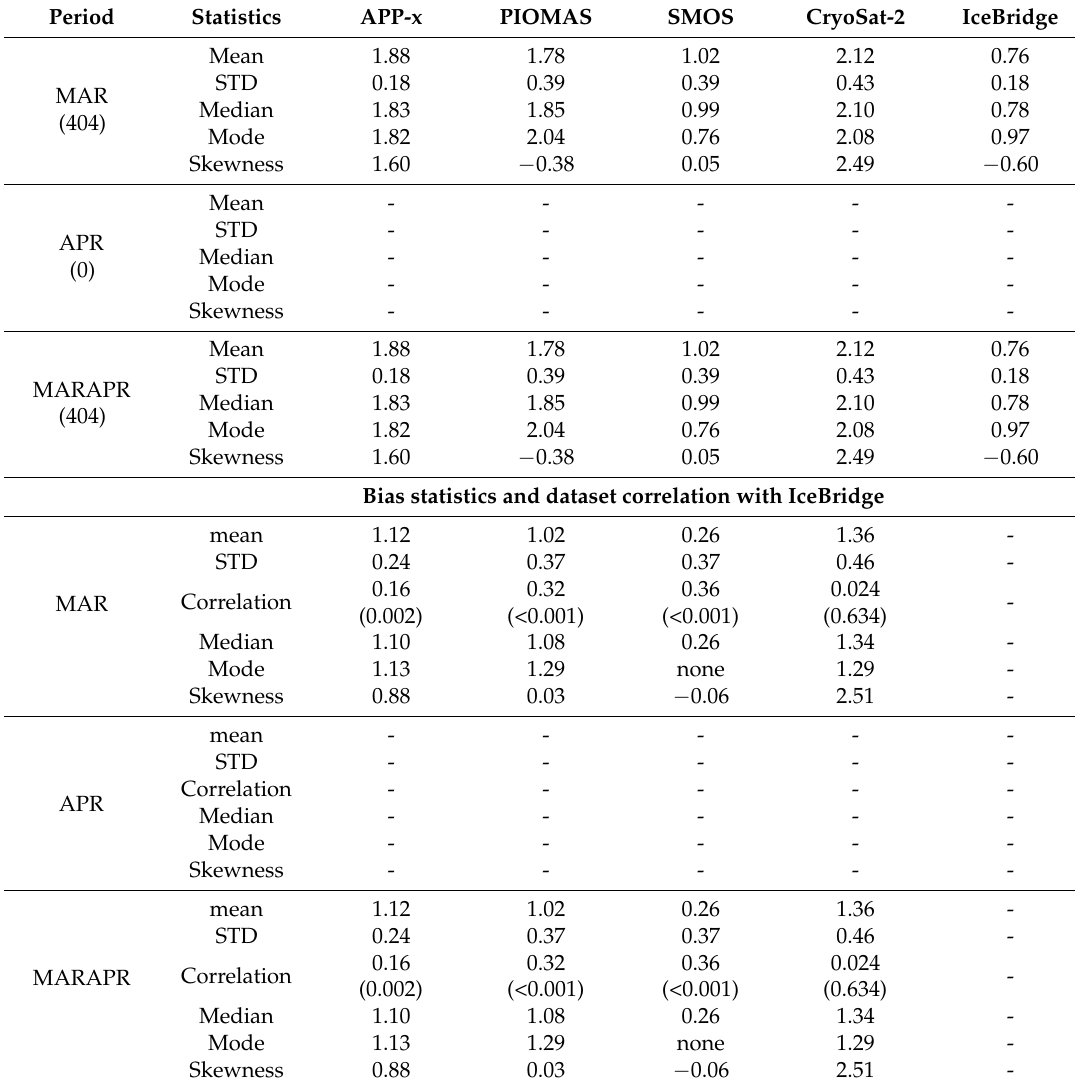
Table 5. Same as Table 4, but for IceBridge thicknesses of 1 m and